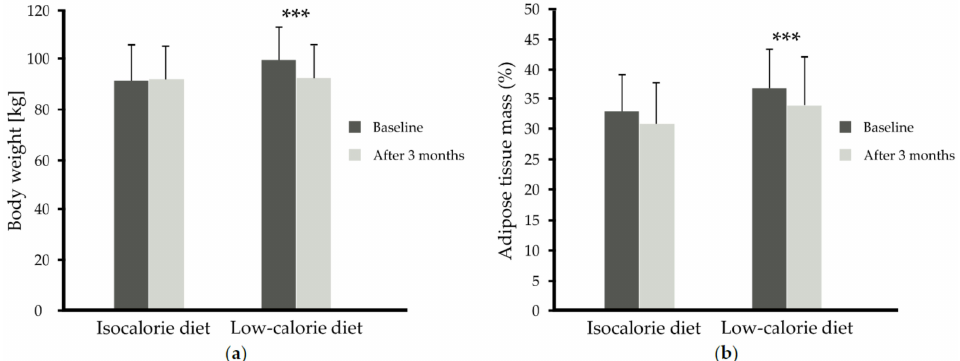
Figure 3. ( a ) Body weight (kg) before and after 3 months of isocaloric diet ( n = 27) intervention or before and after 3 months of low-calorie diet ( n = 37) intervention independent of supplementation, ( b ) adipose tissue mass (%) before and after 3 months of isocaloric diet ( n = 27) intervention or before and after 3 months of low-calorie diet ( n = 37) intervention independent of supplementation data are shown as mean ± SD. Statistics: analyses were performed with repeated measures by ANOVA and Tukey post hoc test; significance: *** p < 0.001 after versus before low-calorie